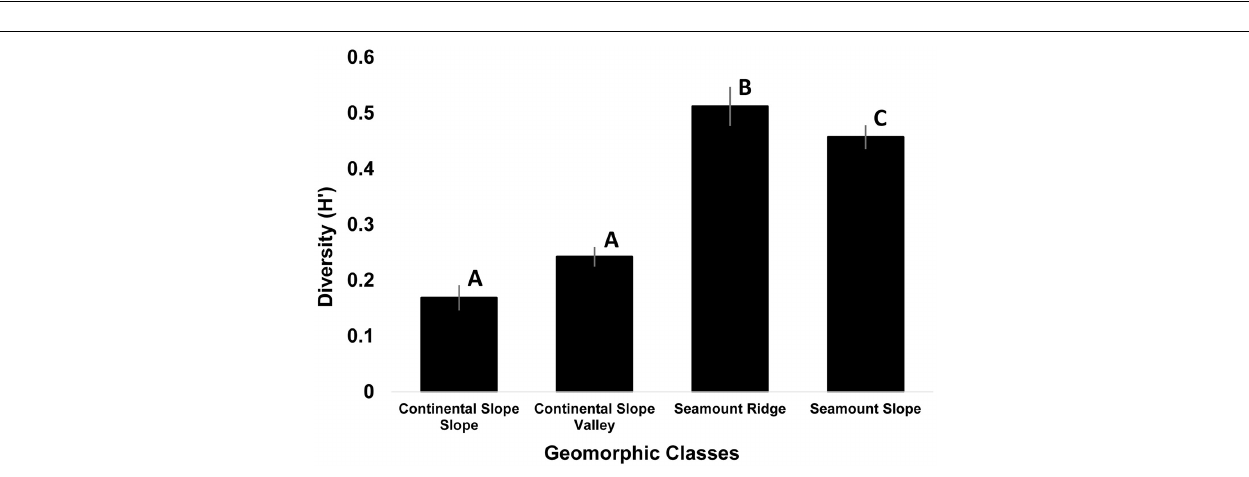
FIGURE 5 | Diversity as a function of geomorphology ( n = 1,105). Washington Canyon was excluded as bathymetry was not collected at this site. Highest diversity was observed on seamounts, specifically seamount ridges. Diversity was significantly different among all geoforms, except for Continental Slope Slope and Continental Slope Valley in which no differences were observed. Error bars represent standard error and different letters denote significant